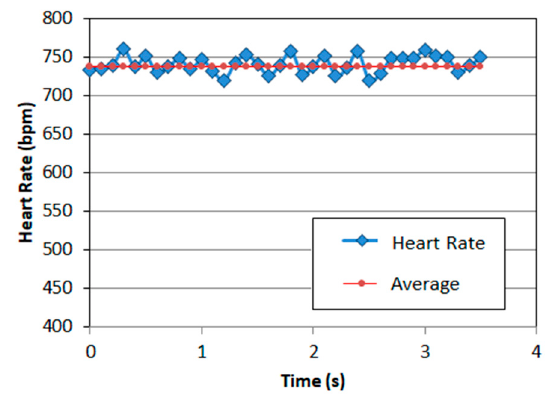
Figure 10. Calculated instantaneous heart rate based on the signal peaks series.